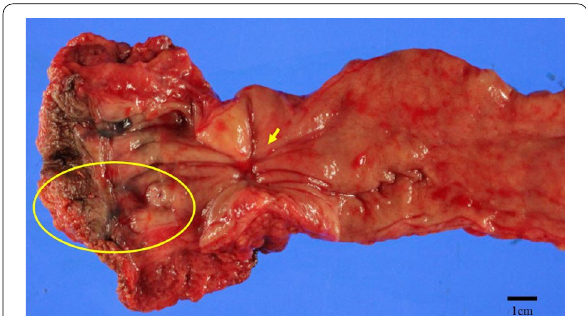
Fig. 4 Gross and pathological findings of rectal cancer. The rectal lesion measures 10 10 mm and is classified as a type 2 tumor. × Histopathologic evaluation showed an adenocarcinoma (tub1), ypT2, INFb, Ly0, V0, Pn0, pPM0, pDM0, ypN0 (arrow). The therapeutic effect grade was grade 2 [11]. There are no cancer remnants in the scar after anal fistula surgery